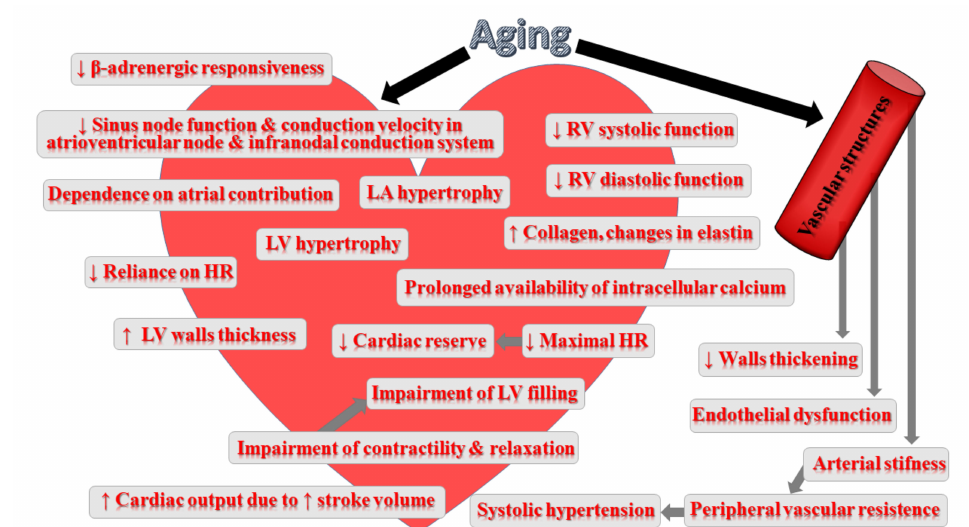
Figure 2. The impact of ageing on cardiovascular system. Abbreviations: HR- heart rate; LA—left atrium; LV—left ventricle; RV—right ventricle, ↑ - increased; ↓ -